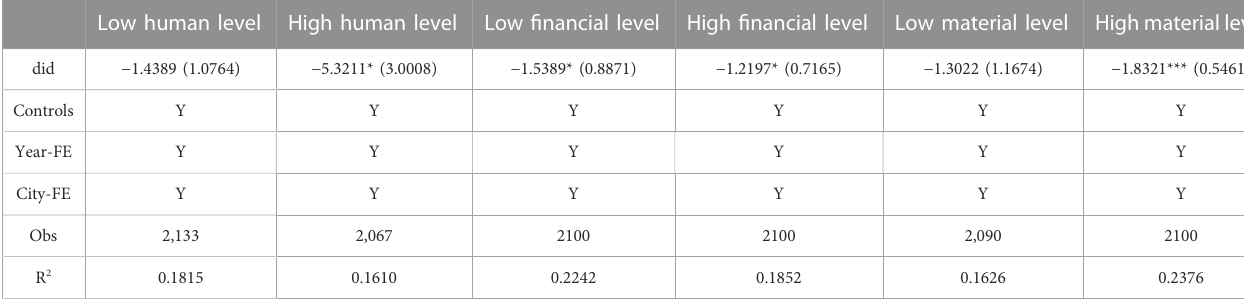
TABLE 9 Heterogeneous analysis based on city